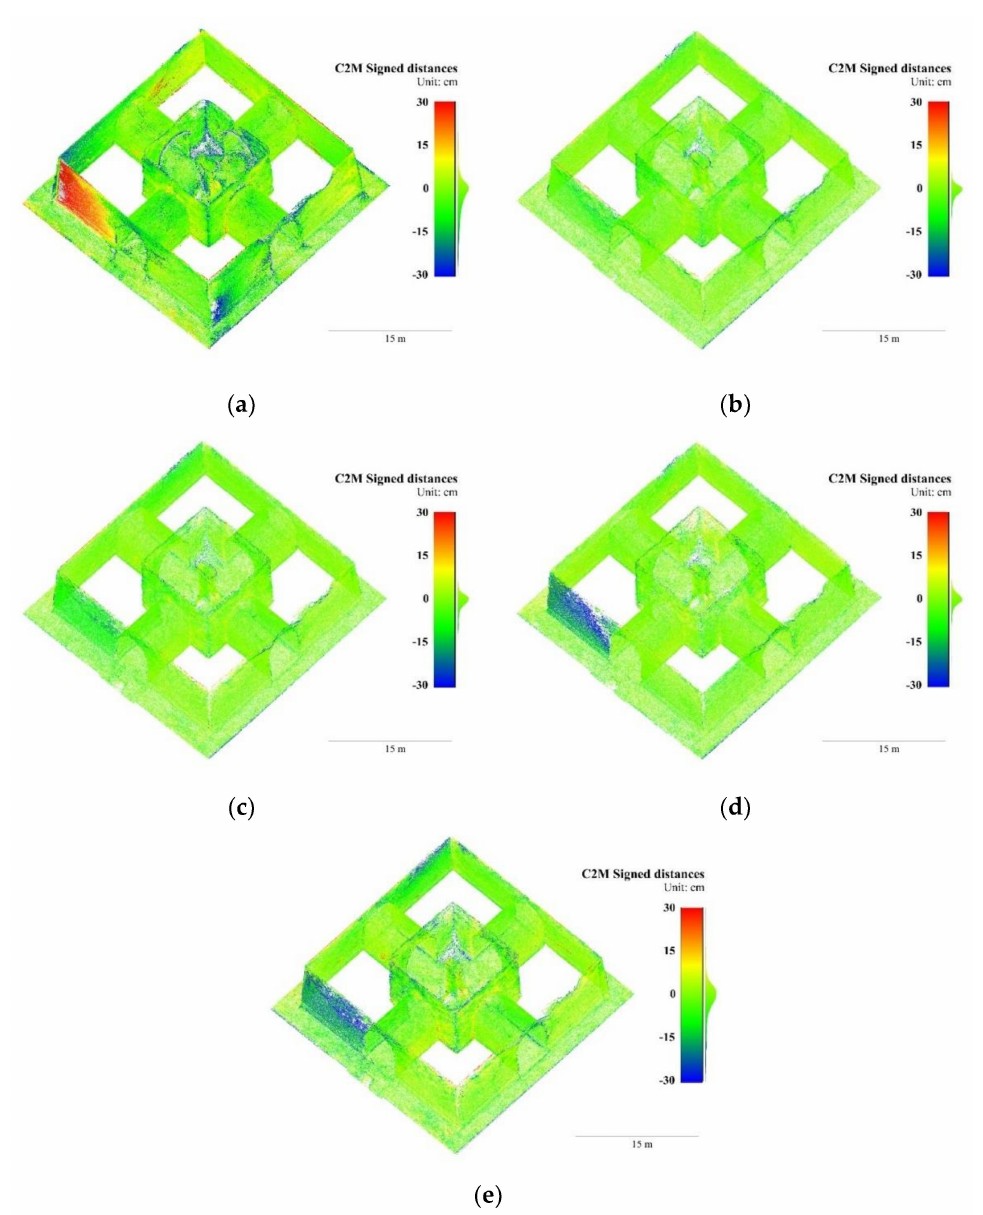
Figure 8. 3D points colored in signed distances to the GTM with variable baselines of the Stupa. ( a ) B 10 ; ( b ) B 20 ; ( c ) B 30 ; ( d ) B 40 ; and ( e ) B 50